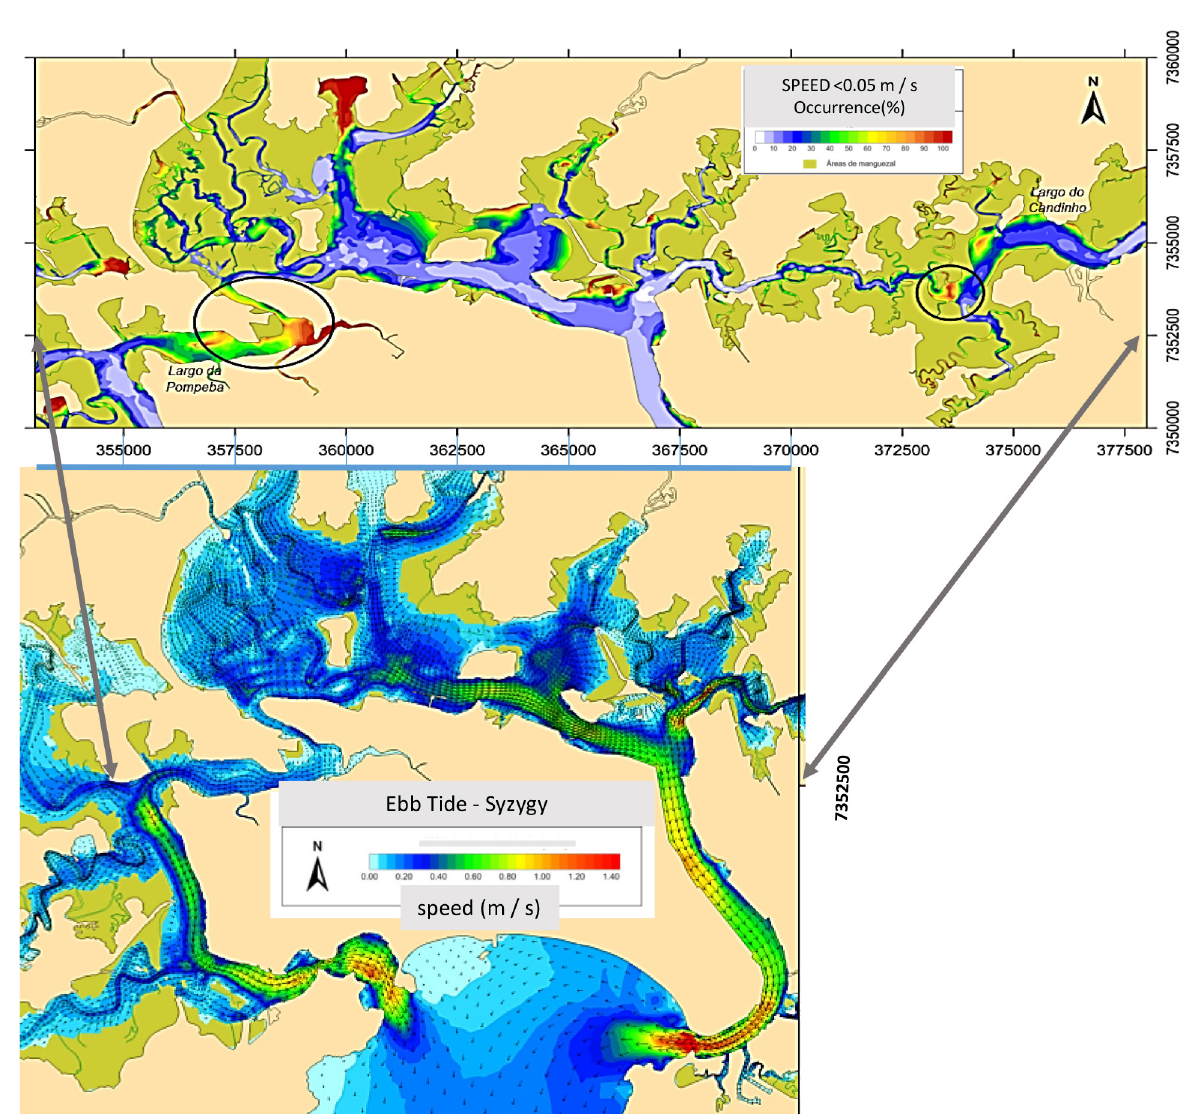
Fig. 2. Extreme hydrodynamic scenarios. Below: maximum speed, caused by the ebb tide. Above: places of occurrence of zero currents (modified from Roversi et al.